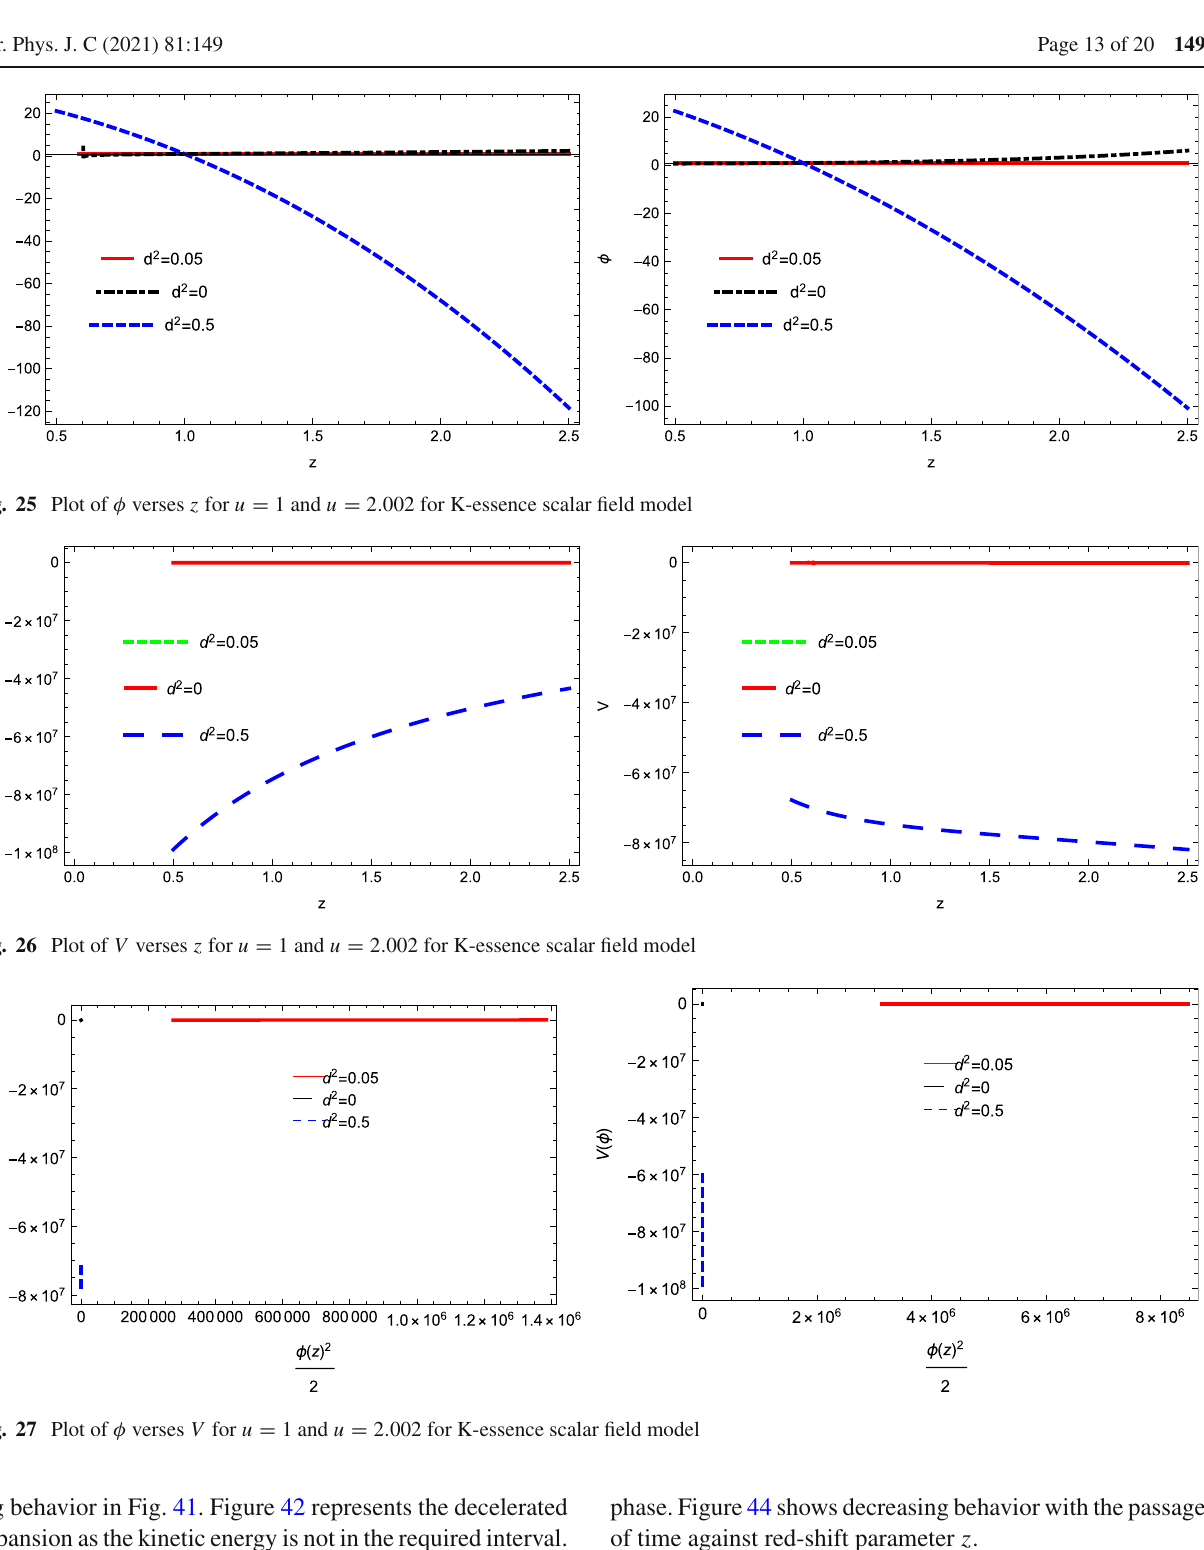
ing behavior in Fig. 41. Figure 42 represents the decelerated expansion as the kinetic energy is not in the required